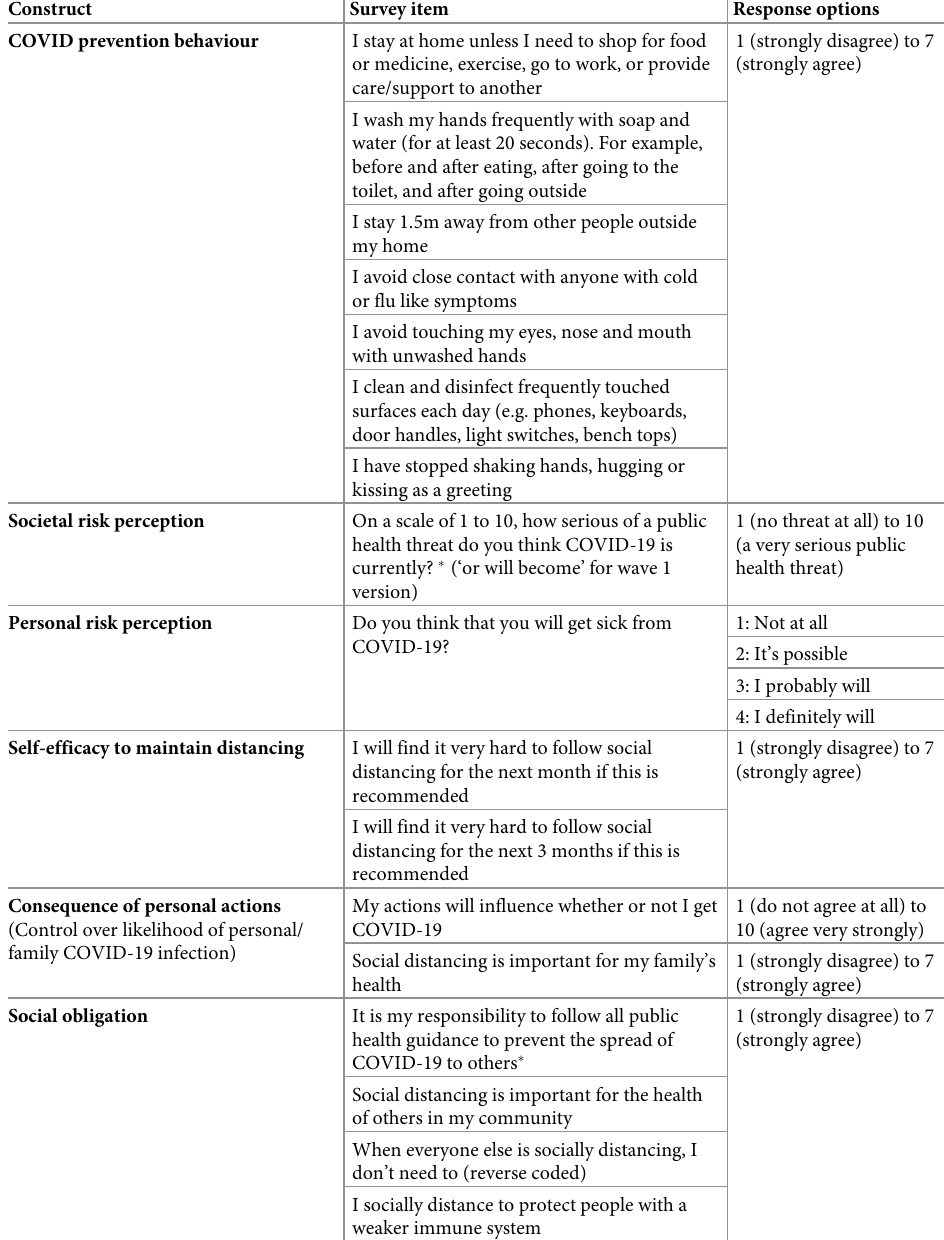
Table 1. Items used to assess COVID prevention behaviours and related psychosocial